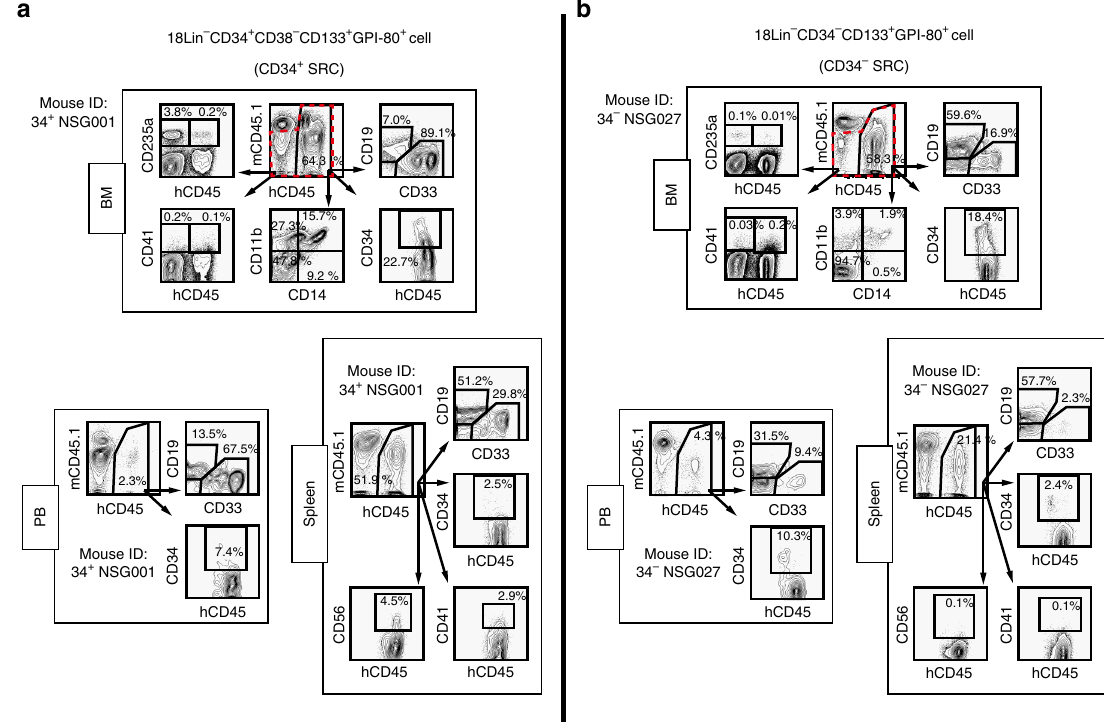
Fig. 3 Human multi-lineage hematopoietic repopulation abilities of single CD34 + and CD34 − SRCs. Human multi-lineage hematopoietic repopulations in the primary recipient NSG mice that received a single 18Lin − CD34 + CD38 − CD133 + GPI-80 + (Mouse ID: 34 + NSG001) or b single 18Lin − CD34 − CD133 + GPI-80 + (Mouse ID: 34 − NSG027) cells were analyzed by 6-color FCM at 22 or 21 weeks after transplantation. The expression of CD19, CD33 CD34 (BM, PB and spleen), CD11b and CD14 (BM), CD41 (BM and spleen), CD235a (BM) and CD56 (spleen) in living human CD45 + cells was analyzed. The presence of CD41 + and CD235a + cells in BM was analyzed using a human CD45 + / − cell gate (depicted by red dotted lines). The mouse ID numbers presented in the fi gure corresponded those listed in Supplementary Data 3a. Analyses of the BM (other bones), PB and spleens of the two representative mice that received either CD34 + SRC a or CD34 − SRC b revealed that both SRCs had an in vivo differentiation capacity comparable to that of CD34 + stem/progenitor cells, CD19 + B-lymphoids, CD33 + /CD11b + myeloids, CD14 + monocytes, CD235a + erythroid and CD41 + megakaryocytic lineages. CD56 + NK cells were detected in the spleen. These results con fi rmed that both CD34 + and CD34 − SRCs had de fi nite multi-lineage differentiation potential. Detailed FCM data of all recipient mice that received single CD34 + and CD34 − SRCs are presented in Supplementary Data